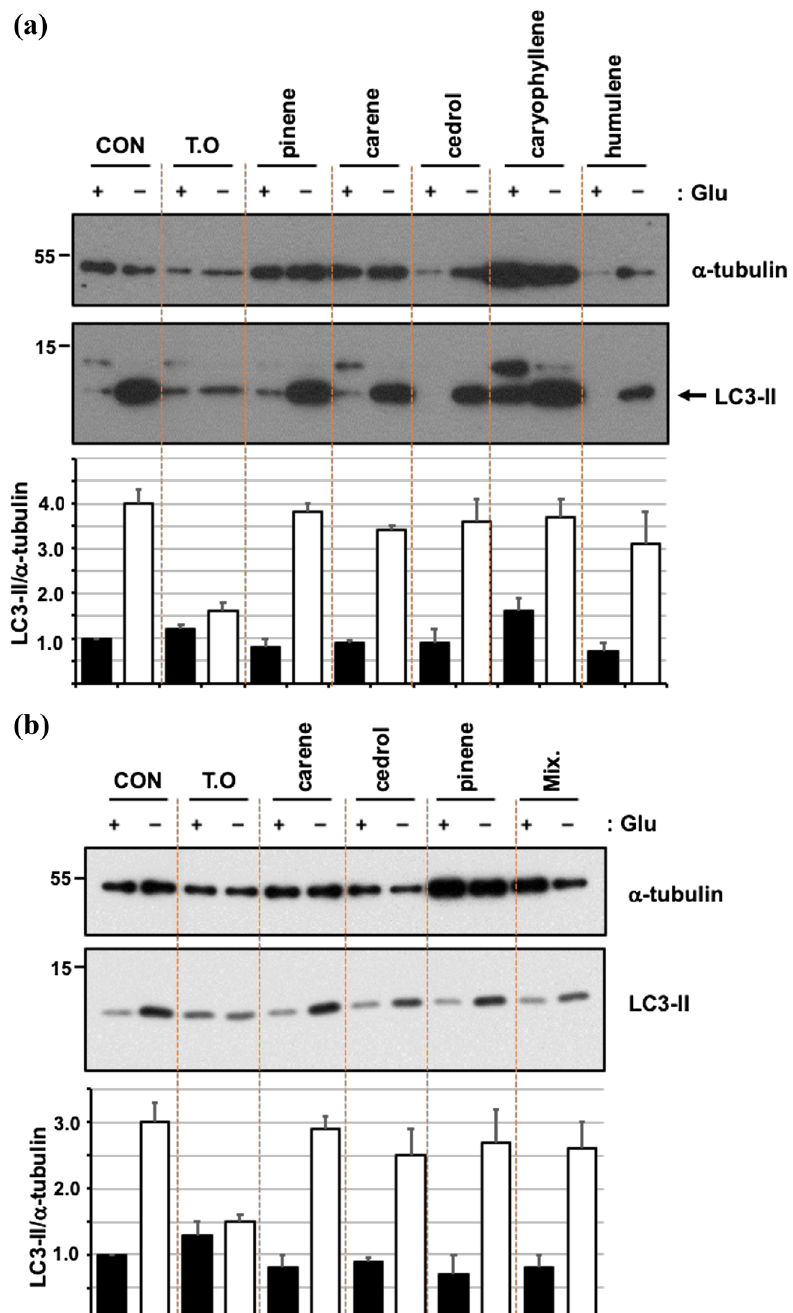
Figure 4. Evaluation of major components in T. orientalis (T.O) for the inhibition of the starvation-induced autophagy. ( a ) MEFs were starved for glucose (Glu) overnight, in which five major components (more than 5% in the extract total) have treated at the following concentrations: α-pinene, 123 μM; Δ-3-carene, 392.5 μM; α-cedrol, 112.3 μM; β-caryophyllene 1.1 mM; and α-humulene, 169.9 μM. ( b ) The same experiment was repeated against carene, cedrol, pinene, and the mixture of these three components (Mix.) under 8 h starvation condition. Autophagy and the protein loading in the experiments were examined by immunoblots against LC3-II and α-tubulin, respectively. A representative image from 3–5 different immunoblots and their quantification of LC3-II level/α-tubulin were shown